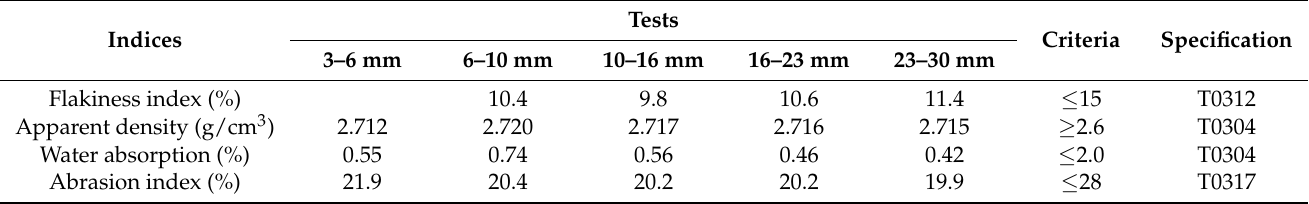
Table 3. Technical properties of the coarse aggregate.